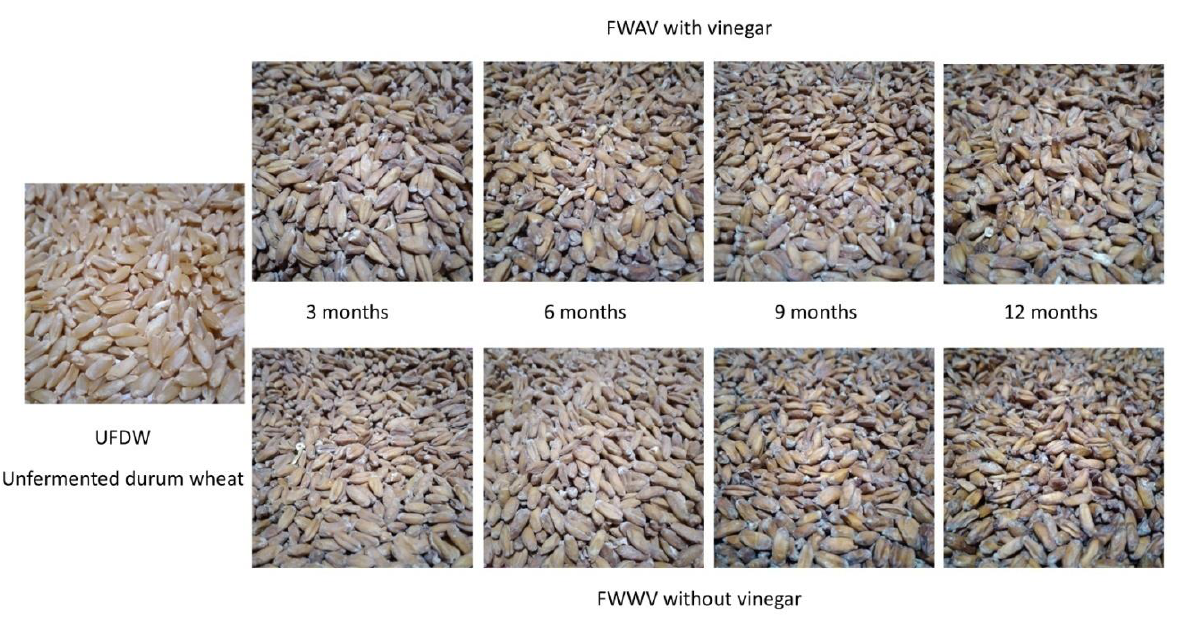
Figure 1. Unfermented durum wheat (UFDW), fermented durum wheat with vinegar (FWAV) and fermented wheat without vinegar (FWWV) after 3, 6, 9 and 12 months of fermentation. 2.4. Enumeration of Total Flora, Yeasts, Molds and Lactic Acid Bacteria